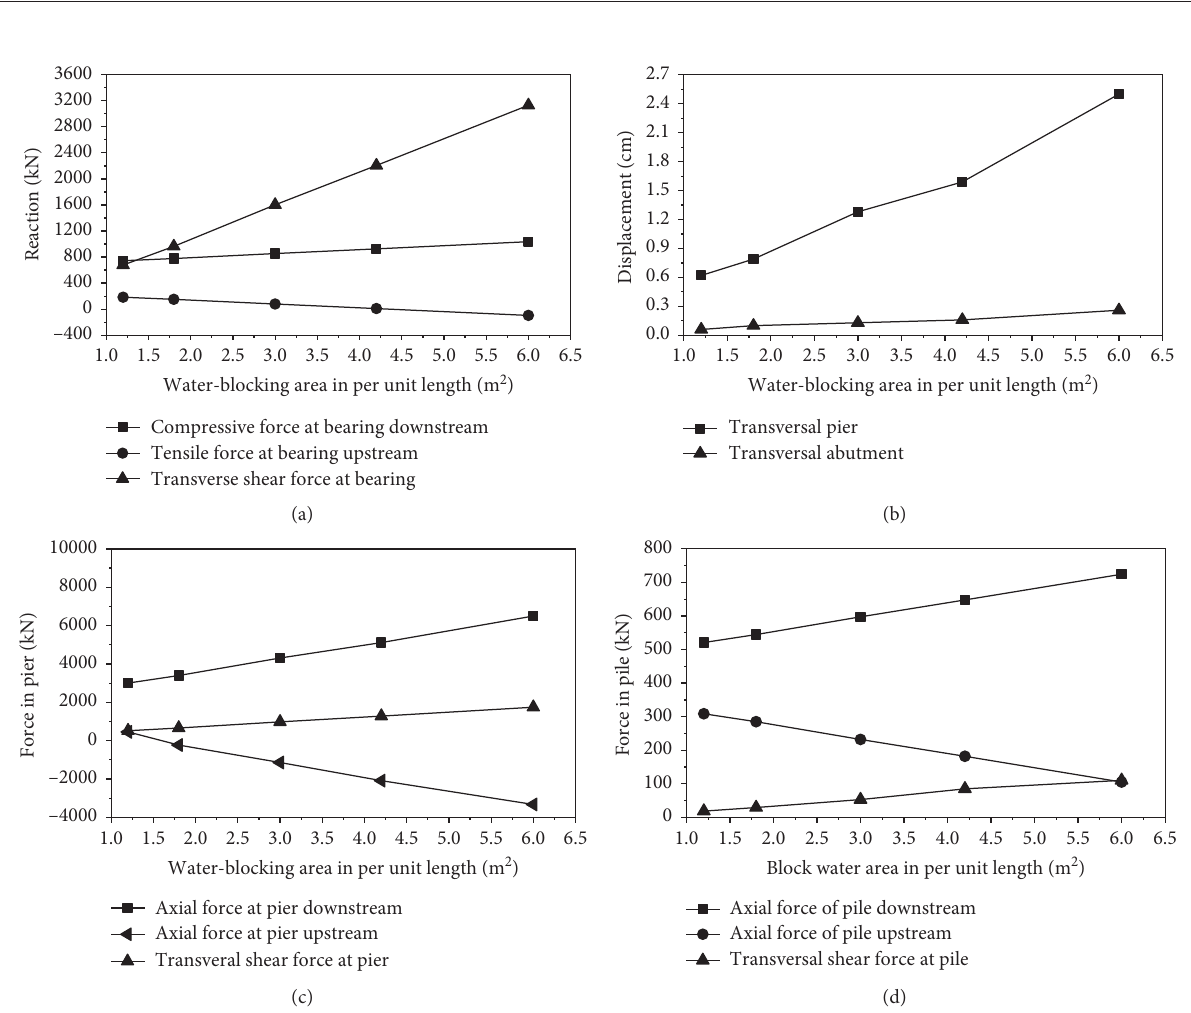
Figure 21: Variation of inner forces of structure and deflections with drag area. (a) Vertical force in bearings. (b) Displacement. (c) Internal force in piers. (d) Internal force in piles.